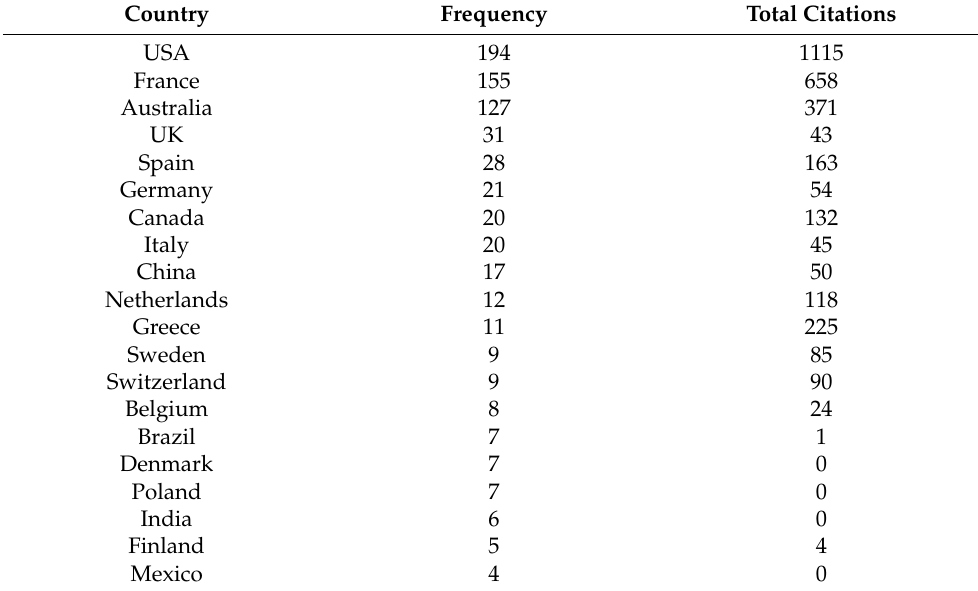
Table 3. Most prolific countries and the number of